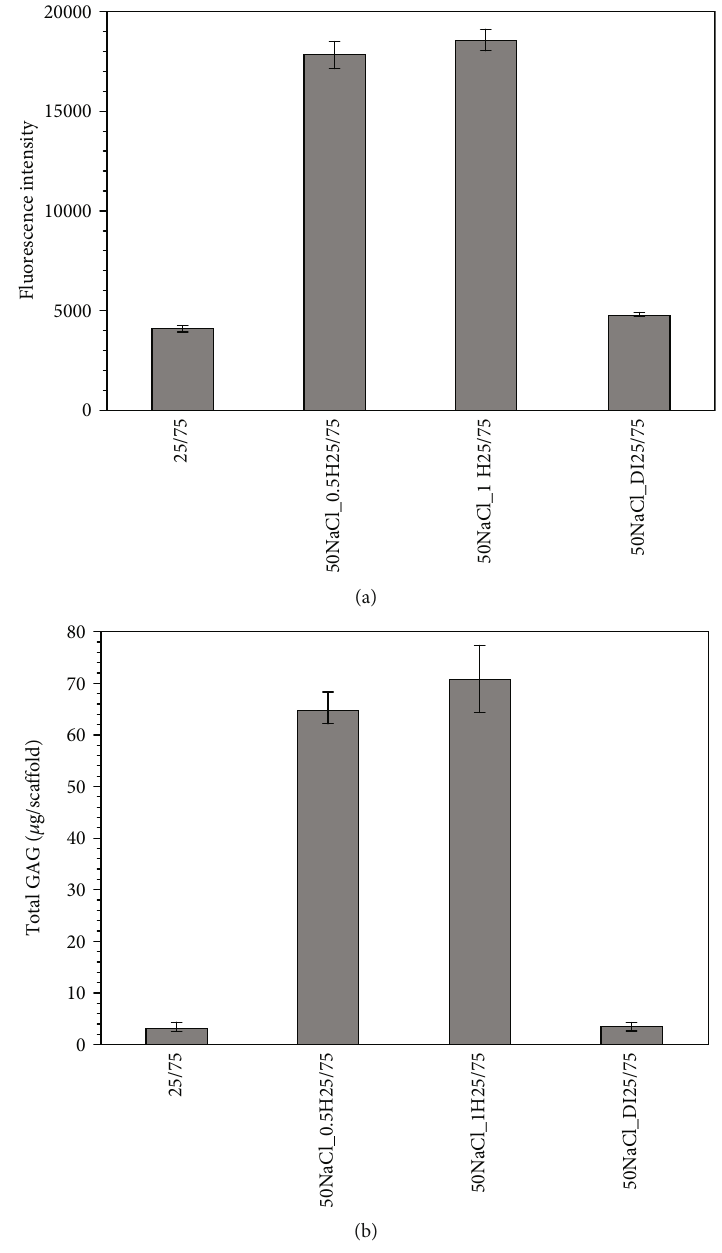
Figure 8: (a) Proliferation of porcine chondrocytes after cultured for 1 day and (b) amounts of extracted glycosaminoglycans after cultured for 28 days on the 25/75 PCL/PHBV sca ff olds with and without local pores and with di ff erent kinds of leaching